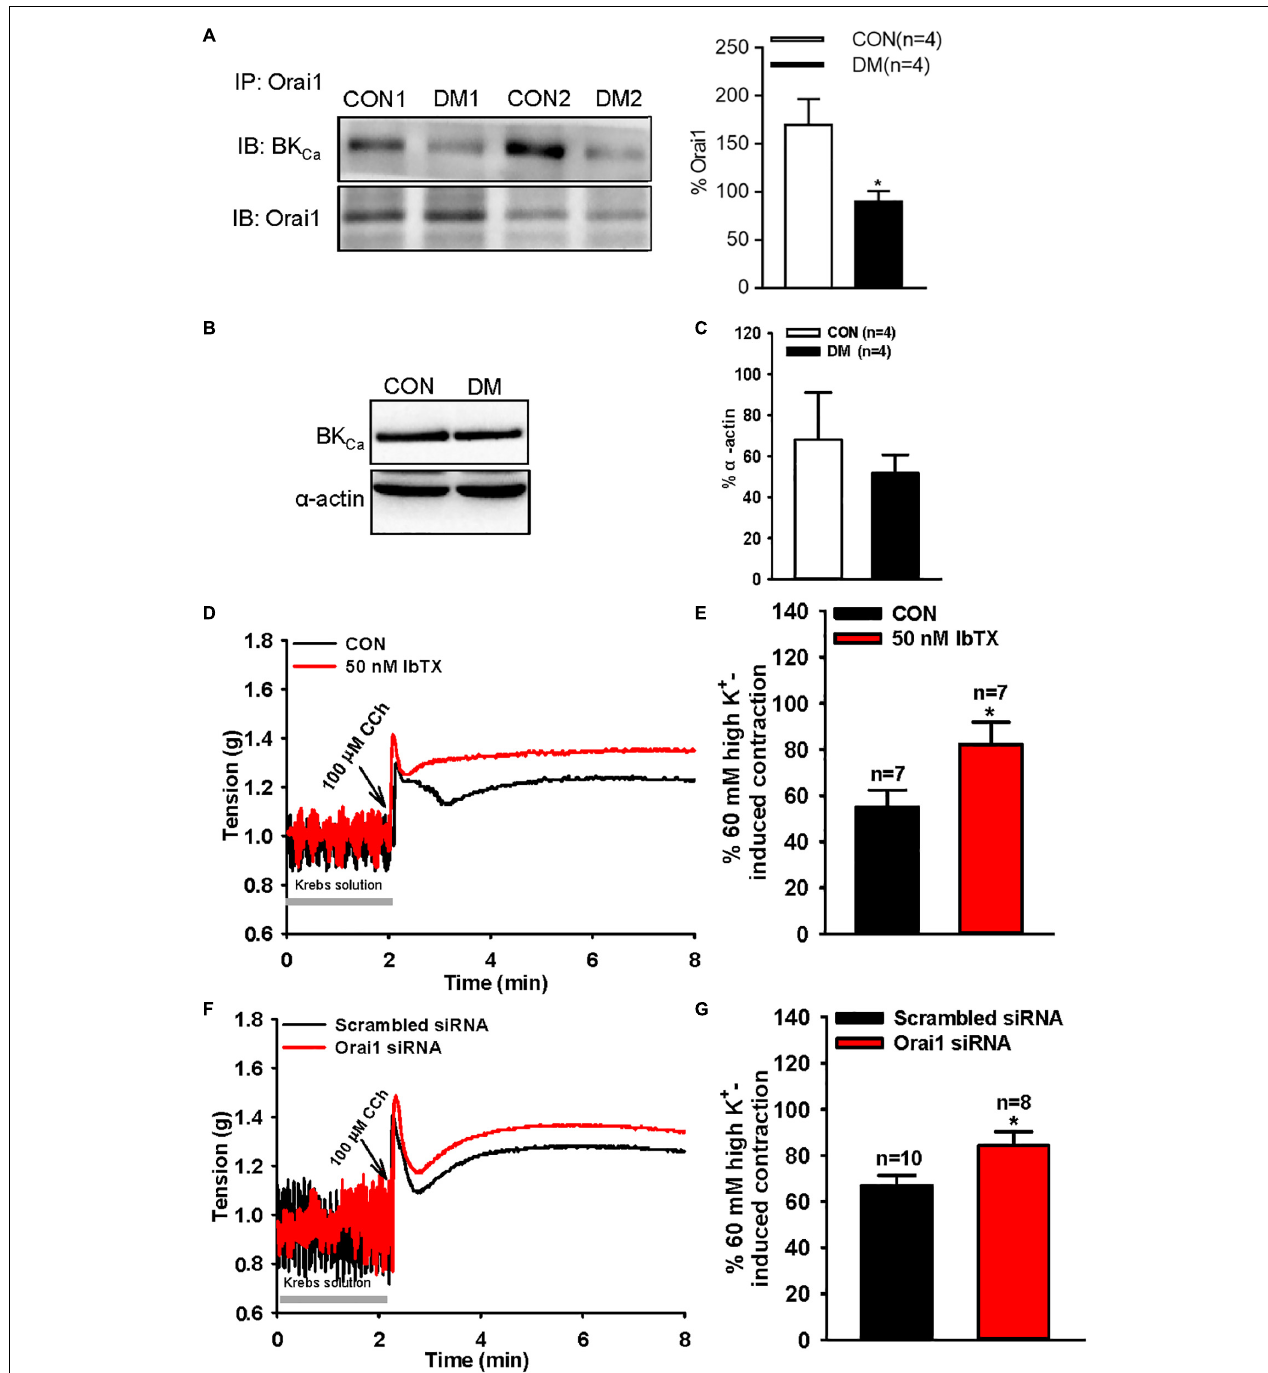
FIGURE 5 | Orai1-BK Ca interaction and BK Ca channel protein expression level alterations in diabetic mouse small intestinal smooth muscle cells and role of store-operated Ca 2 + entry (SOCE) and the BK Ca channel in carbachol (CCh)-induced mouse small intestinal longitudinal contraction. (A) Representative paired images and summarized data showing co-immunoprecipitation followed by immunoblotting (IB) with anti-BK Ca channel or anti-Orai1. Proteins from small intestinal smooth muscle of age-matched control (CON) or diabetic (DM) mice were immunoprecipitated with anti-Orai1 antibody; n = 4 experiments. Representative images (B) and summarized data (C) showing the expression level of the BK Ca channel protein. Alpha-actin was used as a loading control. Values are shown as the mean ± SEM ( n = 4); P > 0.05, age-matched control vs. diabetic mice. Representative traces (D,E) and summarized data (E,G) showing 100 µ M CCh-induced mouse small intestine contractions. The segments of the small intestine were pretreated with 50 nM IbTX for 20 min (D,E) or transfected with scrambled or Orai1 siRNA (F,G) by intraperitoneal injections. Values are shown as the mean ± SEM ( n = 7–10); * P < 0.05, control (CON) vs. IbTX treatment, or scrambled siRNA vs. Orai1